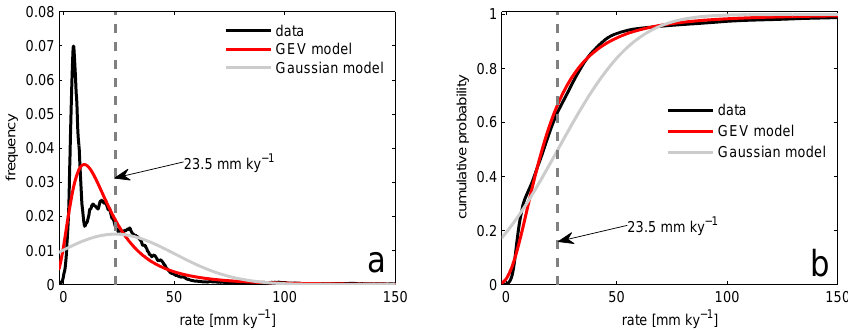
Figure 3. (a) Retreat rate spectrum based on a compilation of four eroded micritic limestone blocks at the Western Wall. Best fits for generalized extreme value (GEV) and Gaussian models are shown. The fitting parameters for the GEV model are µ = 12 . 1mmky − 1 , σ = 10 . 9mmky − 1 , and ξ = 0 . 296; parameters for the Gaussian model are µ g = 23 . 5mmky − 1 and σ g = 27 . 0mmky − 1 . (b) Cumulative distribution functions for the weathering rates shown together with the GEV and Gaussian models.